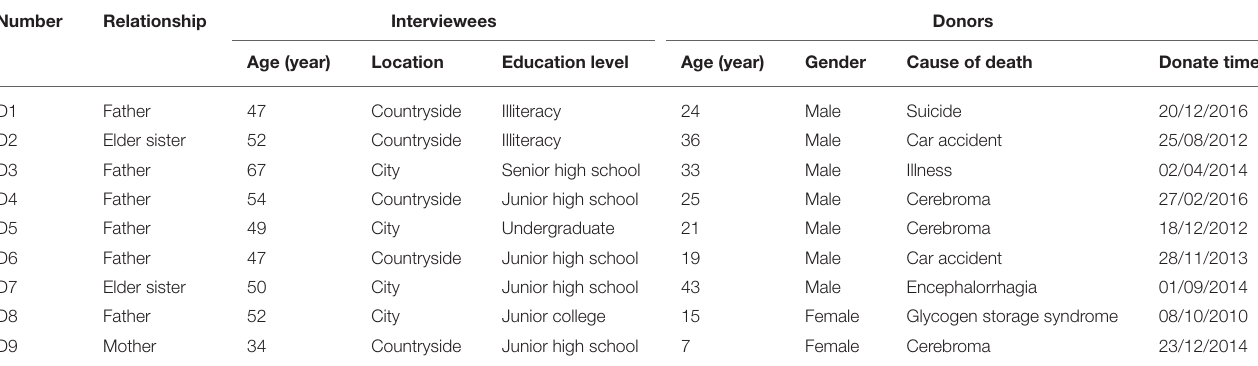
TABLE 8 | General demographic data of